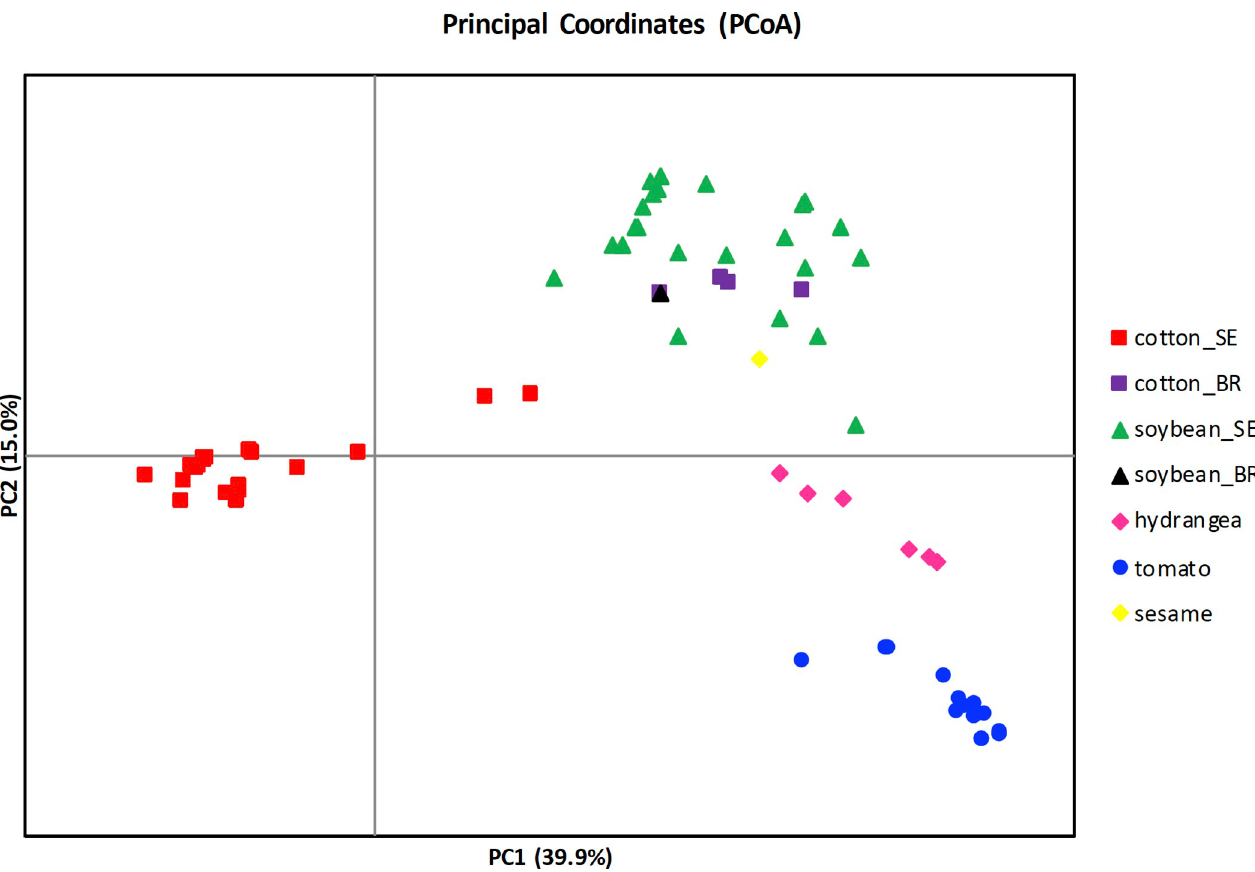
Fig 3. PCoA of 265 Corynespora cassiicola isolates based on pairwise genetic distance of multilocus genotypes. The first two principal coordinates are shown. Genotypes from each host are represented by the shape and color shown in the key. Genotypes from cotton and soybean from the southeastern U.S. (SE) or Brazil (BR) are distinguished by color. The tomato population also includes pepper, cucumber, and mandevilla isolates.